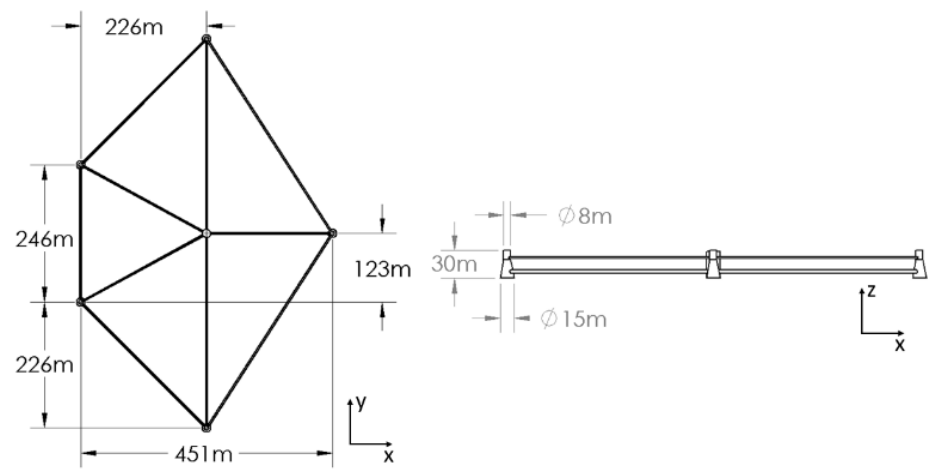
Figure 16. Platform configuration.